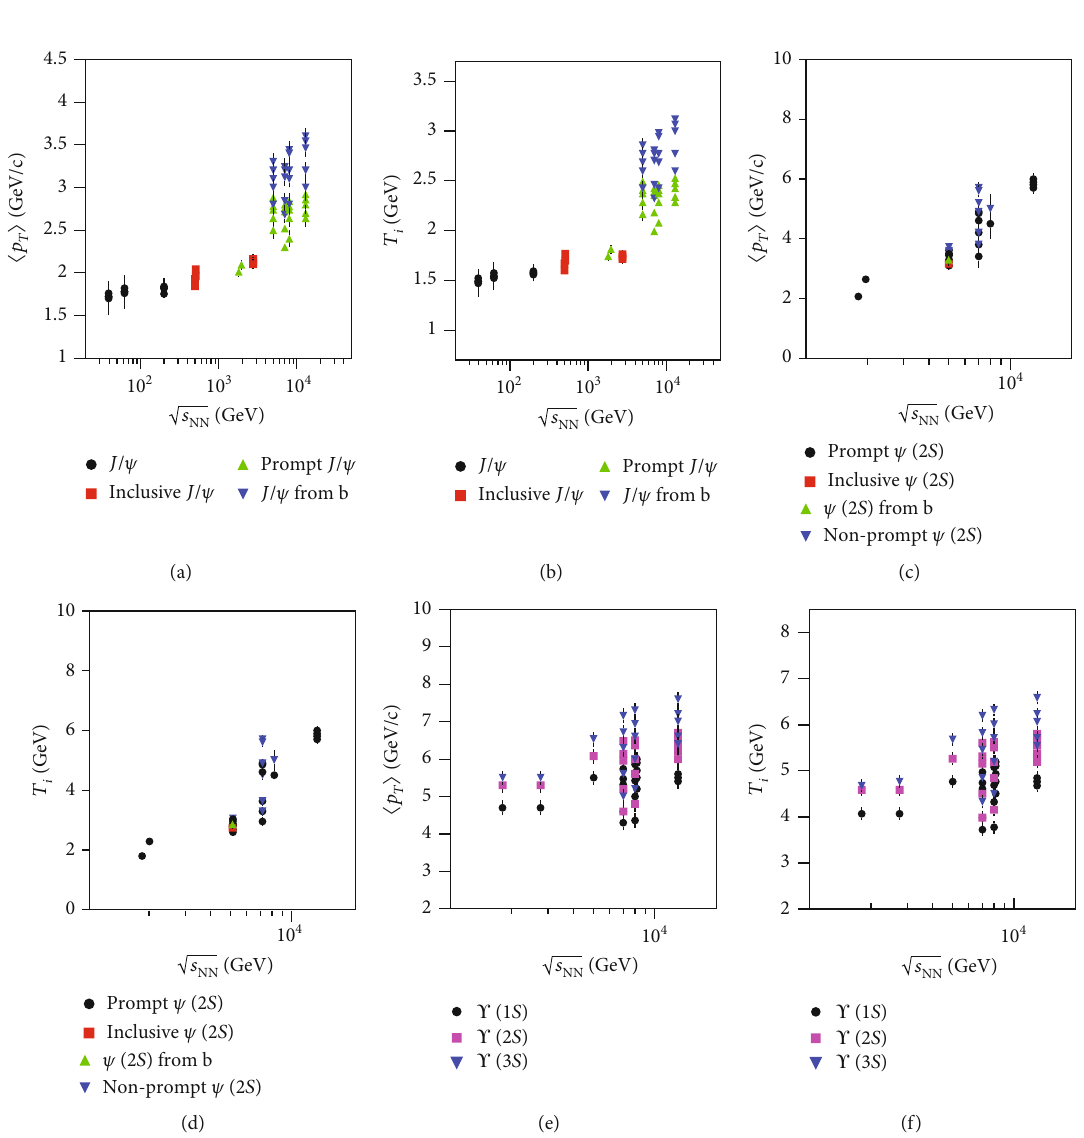
ffiffi p ffiffiffiffiffiffiffi p i and (b, d, and f) T s s (or ) for (a, b) J / ψ , (c, d) ψ ð 2 S Þ , and (e, f) Y ð nS , n = 1, 2, 3 Þ . The i on NN T